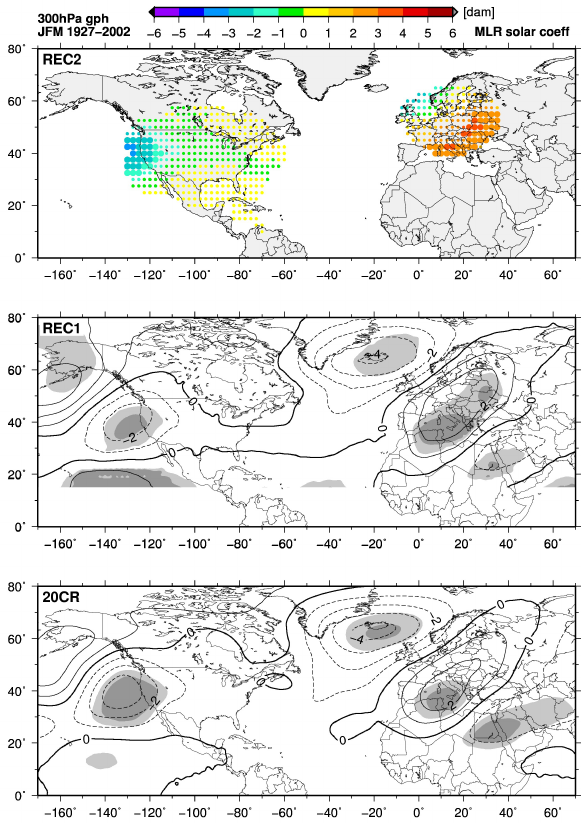
Fig. 6. Same as Fig. 5, but showing the solar coefficient c R (in dam/100 units of R) of a multiple linear regression instead of the composites